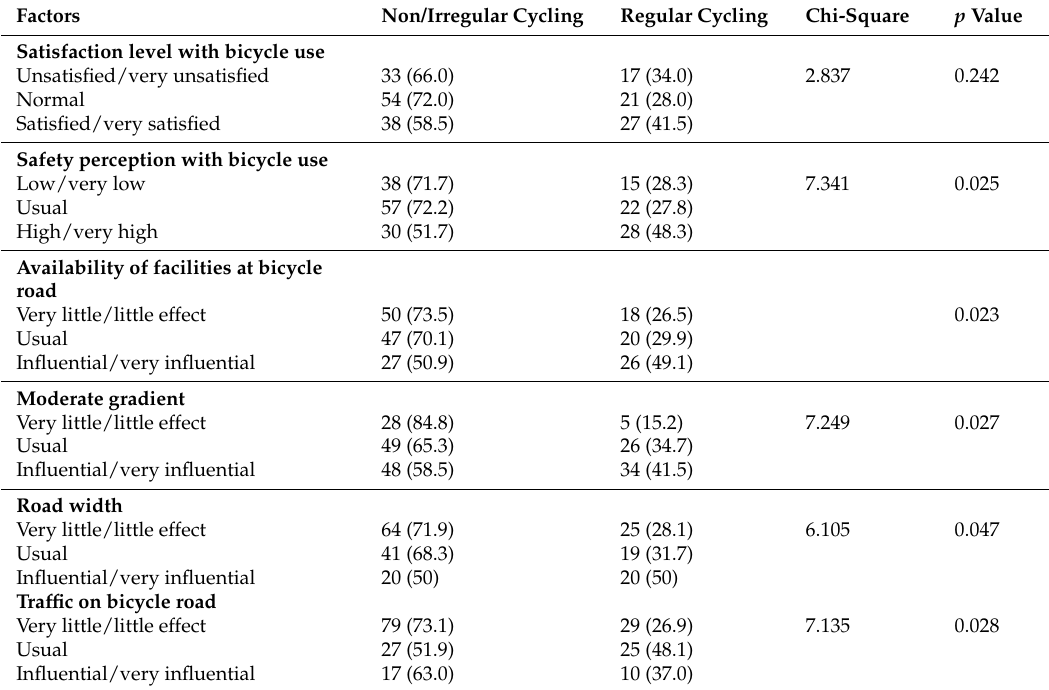
Table 5. Association between the type of cyclist and influential factors for